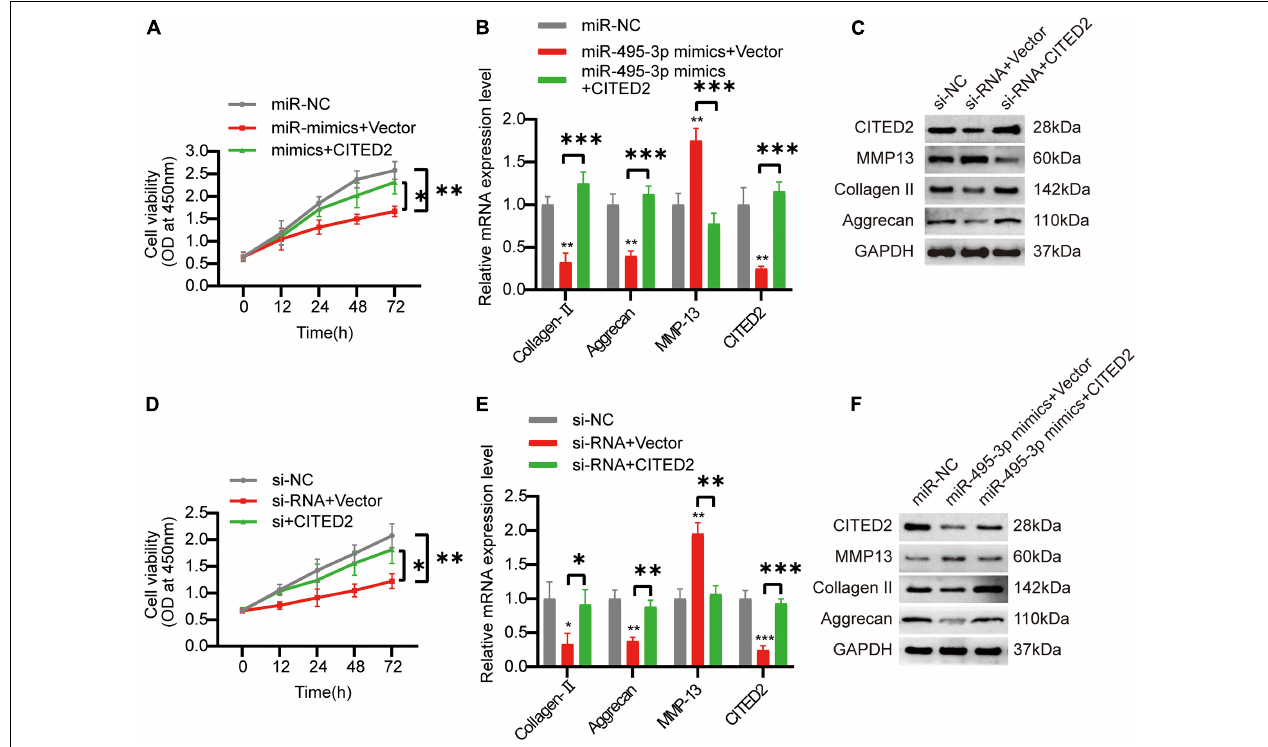
FIGURE 6 | Overexpression of COL5A1 rescues the functional depletion caused by silencing circSNHG5. (A) The effect of CITED2 overexpression on miR-495-3p knockdown-mediated cell proliferation was measured by CCK-8 assay (* P < 0.05, ** P < 0.01). (B,C) CITED2, MMP13, Collagen II, and Aggrecan expression levels were analyzed by qRT-PCR and Western blotting. The presented values are the means ± SD of three different preparations (*** P < 0.001). (D) The effect of CITED2 overexpression on circSNHG5 knockdown-mediated cell proliferation was measured by CCK-8 assay (* P < 0.05, ** P < 0.01). (E,F) CITED2, MMP13, Collagen II, and Aggrecan expression levels were analyzed by qRT-PCR and Western blotting. The presented values are the means ± SD of three different preparations (* P < 0.05; ** P < 0.01; *** P <